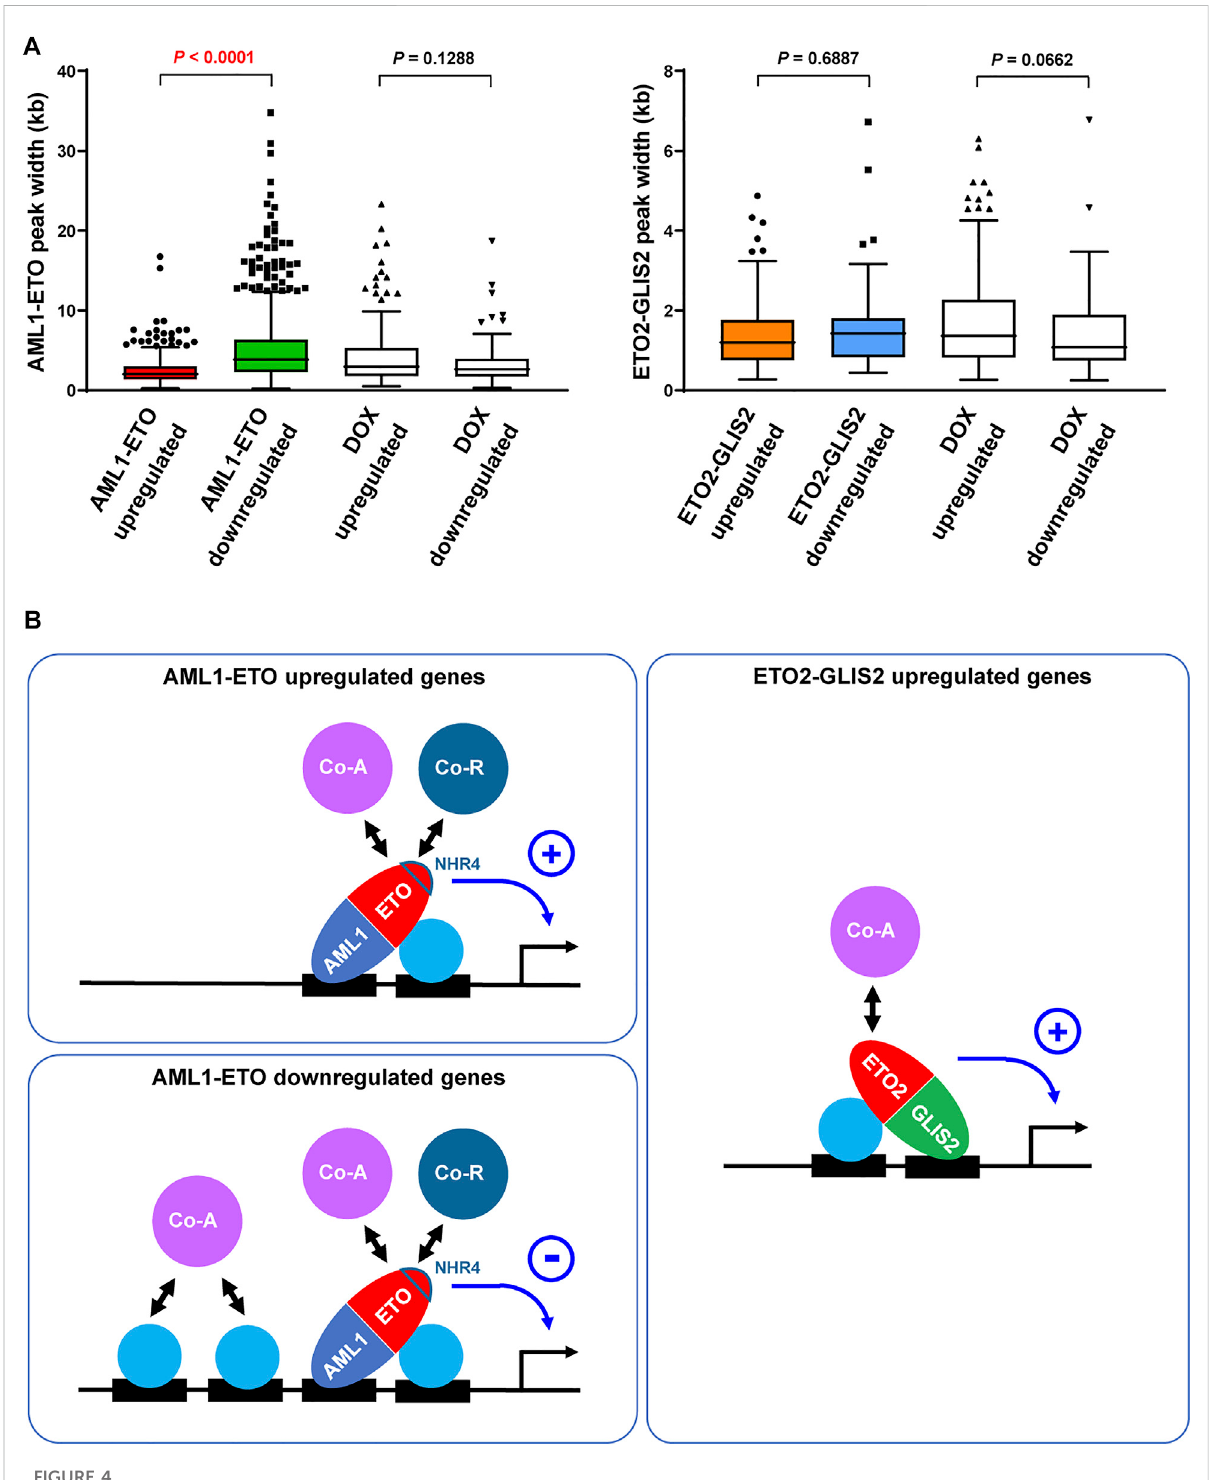
PossiblydifferentfunctionsandmechanismsofAML1-ETOandETO2-GLIS2inregulatingtargetgenes. (A) Signi fi cantlywiderbindingregionsof AML1-ETO at the promoters of the downregulated relative to upregulated genes. This trend was not seen for the genes altered by DOX or for the ETO2-GLIS2bindingregions. (B) AworkingmodelexplainingthattheactivitiesAML1-ETOasarepressorversusactivatormightbedeterminedbythe abundance of cooperative transcription factors and cofactors on target genes. In contrast, ETO2-GLIS2 mainly acts as a transcriptional activator. The AML1-ETO NHR4 domain, which is absent from ETO2-GLIS2, is highlighted because it may partially account for the different properties of these two fusion proteins. The circled plus and minus denote active and repressive activities, respectively. Co-A, coactivator; Co-R,